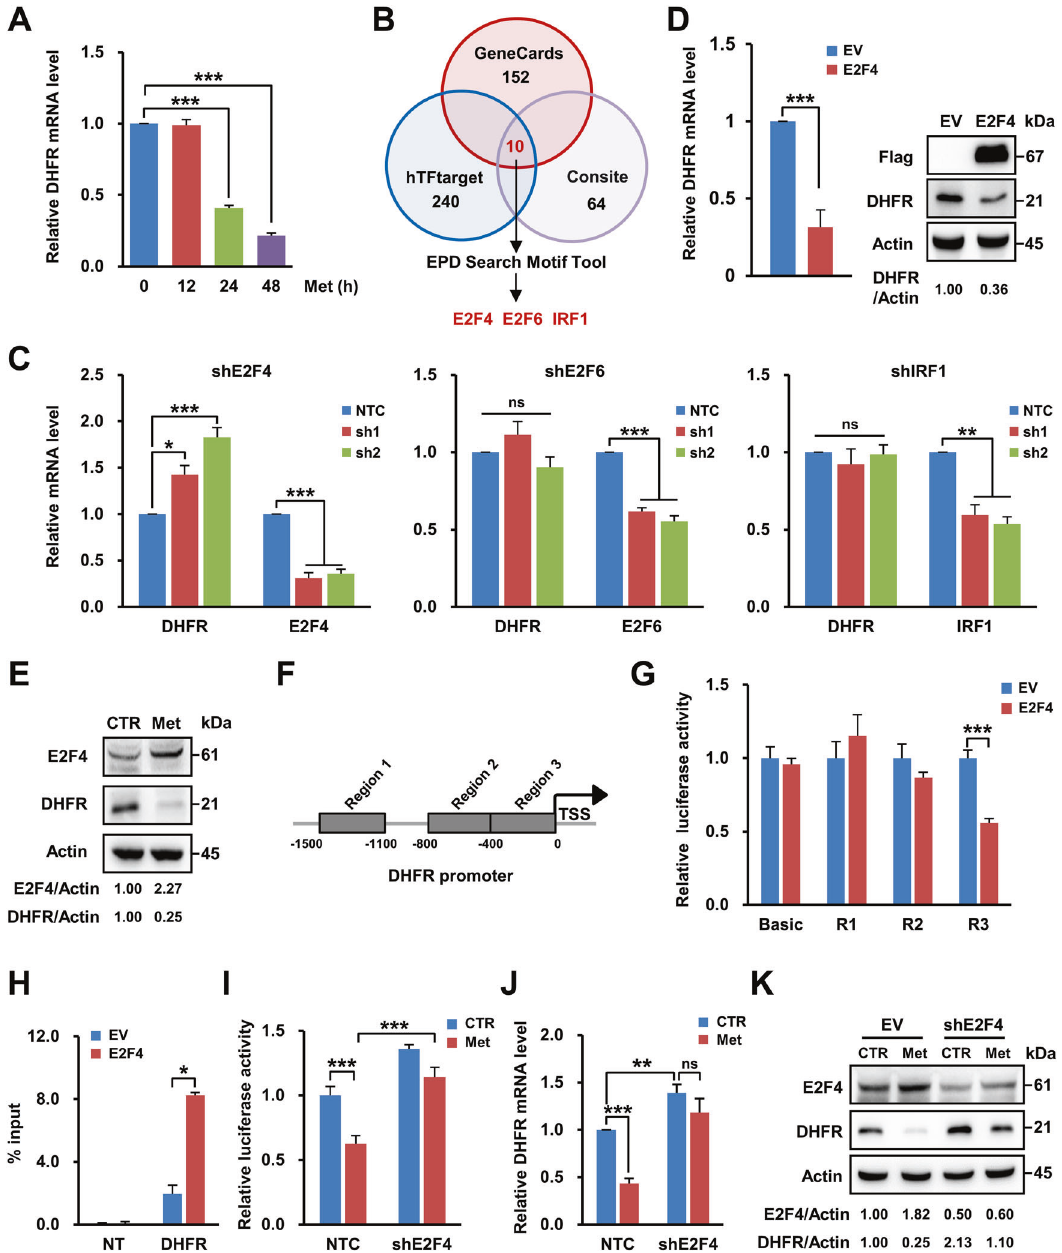
Fig. 2 Metformin transcriptionally suppresses DHFR via E2F4. A qRT-PCR analysis of DHFR mRNA levels in HepG2 cells treated with metformin (2.5 mM) for the indicated hours. B Diagram of the strategy for screening possible transcription factors (TFs) that regulate DHFR. TFs that might bind to the DHFR promoter ( − 1000 to 0) were collected from TF prediction websites, including GeneCards, hTFtarget and Consite. The common transcription factors that might bind to the DHFR promoter were further validated by the EPD motif tool. C qRT-PCR analysis of the mRNA levels of DHFR and E2F4, E2F6 or IRF1 in HepG2 cells expressing NTC shRNA or shRNAs against E2F4 (shE2F4), E2F6 (shE2F6) or IRF1 (shIRF1), respectively. D qRT-PCR and western blot analyses of DHFR expression in HepG2 cells expressing 3XFlag-EV or 3XFlag-E2F4. E Western blot analysis of the expression of E2F4 and DHFR in HepG2 cells treated with metformin (2.5 mM) for 48 h. F A diagram showing the potential E2F4 binding regions in the DHFR promoter. Regions 2 and 3 contain several potential E2F4 binding sites. Region 1 was used as the negative control. G A dual-luciferase assay was performed to identify E2F4 binding regions in the DHFR gene. Different regions containing predicted binding sites were inserted into a luciferase reporter vector. E2F4 was co-transfected with pGL3-Basic-Region 1 (R1), pGL3-Basic-Region 2 (R2) or pGL3-Basic-Region 3 (R3). H ChIP-qPCR analysis of E2F4 occupancy in the binding region in the DHFR gene in HepG2 cells using IgG or an anti-E2F4 antibody. I Luciferase assays were performed to determine the transcriptional activity of DHFR via E2F4 with or without metformin (2.5 mM) treatment. J qRT-PCR analysis of DHFR mRNA levels in HepG2 cells expressing NTC shRNA or shRNA against E2F4 (shE2F4) under metformin (2.5 mM) treatment for 24 h. K Western blot analysis of the expression of E2F4 and DHFR in HepG2 cells expressing NTC shRNA or shRNA against E2F4 under metformin (2.5 mM) treatment for 48 h. Band intensities for protein expressions in the western blot assay were quantitated by ImageJ and normalised to Actin. Data are presented as the mean (±SEM) or mean (±SD) values. Statistical signi fi cance was assessed by Student ’ s t -test or ANOVA followed by Dunnett ’ s or Tukey ’ s multiple comparisons test. *, **, and *** indicate P < 0.05, 0.01, and 0.001, respectively, compared between the indicated groups. ‘ ns ’ indicates no signi fi cant difference between the indicated